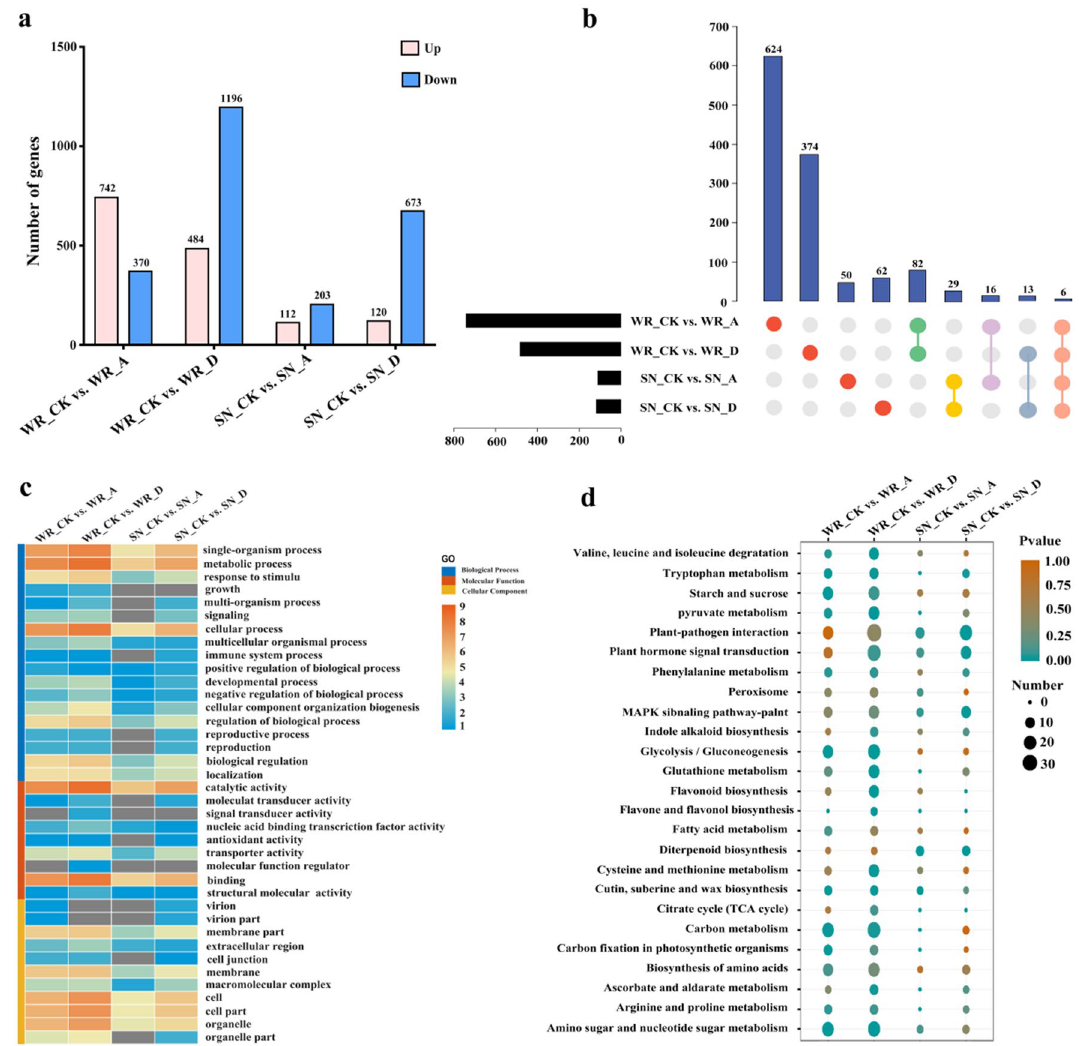
Figure 4. Plot of differentially expressed genes (DEGs) from different comparisons of samples from WR04-6 and SN9816 plants after ABA and diniconazole treatments. ( a ) Numbers of DEGs resulting from pairwise comparison of samples between WR04-6 and SN9816 after ABA and diniconazole treatments. A in WR_A or SN_A indicates ABA treatment, D in WR_D or SN_D indicates diniconazole treatment, and CK in WR_CK or SN_CK indicates the control group without treatment. ( b ) Congruence of the up-regulation of DEGs from pairwise comparisons of samples after treatment with ABA or diniconazole in WR04-6 and SN9816 plants. Red represents DEGs uniquely expressed in each treatment for WR04-6 and SN9816 plants; green represents DEGs uniquely expressed in WR_A and WR_D; yellow represents DEGs uniquely expressed in SN_A and SN_D; purple represents DEGs uniquely expressed in WR_A and SN_A; Blue-grey represents DEGs uniquely expressed in WR_D and SN_D; and pink represents DEGs uniquely expressed after both ABA and diniconazole treatments in the two varieties. ( c ) GO enrichment analysis of the differentially expressed genes presented as a heat map. ( d ) KEGG enrichment analysis of differentially expressed genes presented as a bubble and only one was down-regulated (Fig. 5a). There were eight genes related to peroxidase in the WR_CK ver- sus WR_D group, of which only three ( LOC_Os04g53210 , LOC_Os09g32290 , and LOC_Os08g44360 ) were up- regulated. A smaller number of genes with altered expression levels were identified in SN9816 than in WR04-6 when exposed to ABA and diniconazole. One down-regulated and two up-regulated genes were identified in a